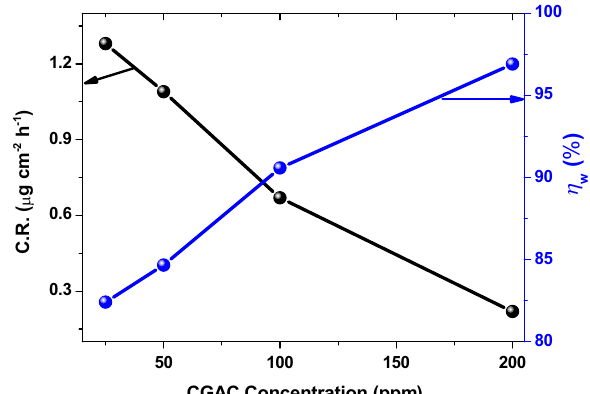
Figure 8. Dependence of the corrosion rate ( C.R. ) and protection efficiency ( ɳ w %) obtained from the weight loss method, on the CGAC nanopowder dose in the coating.